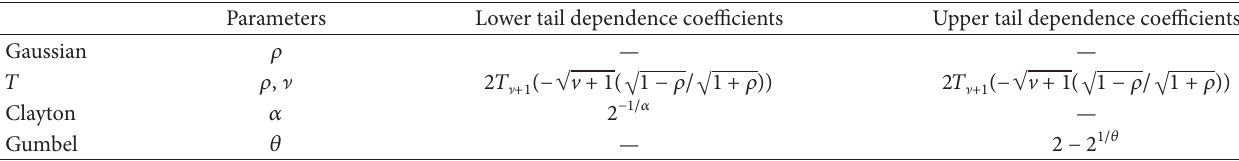
Table 1: Parameters and tail dependence coefficients of various